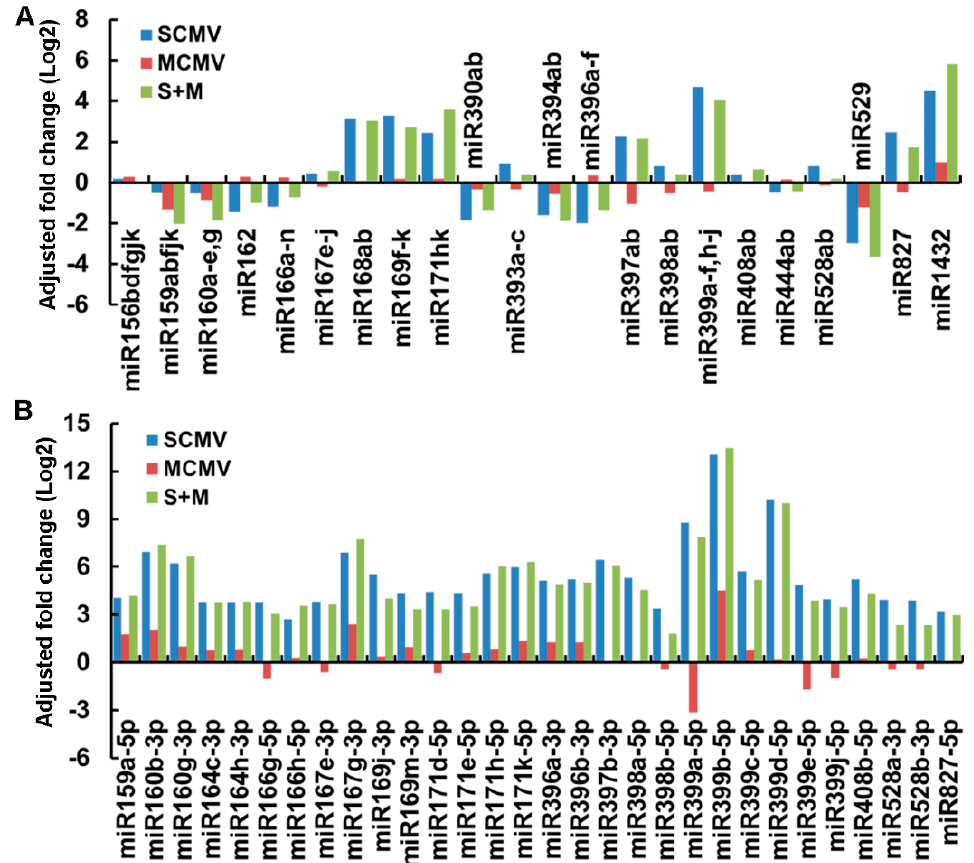
Figure 2. Differential expression of microRNAs (miRNAs) ( A ) and miRNA*s ( B ) in SCMV-, MCMV-, and S + M-infected maize plants.